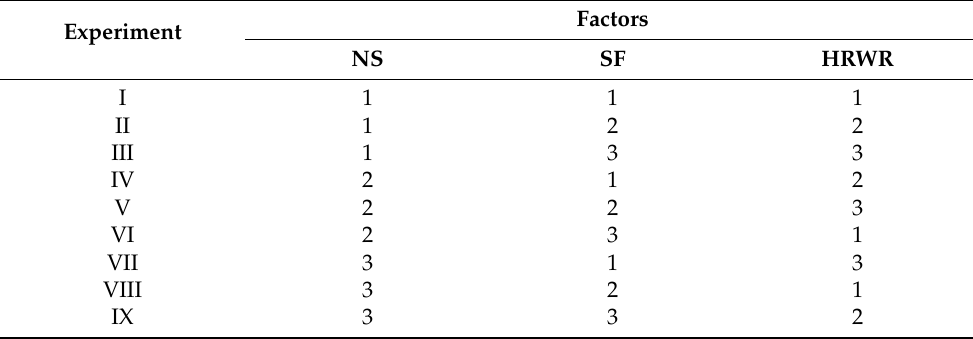
Table 5. Orthogonal array L9 with factors levels assignment for the experiments.